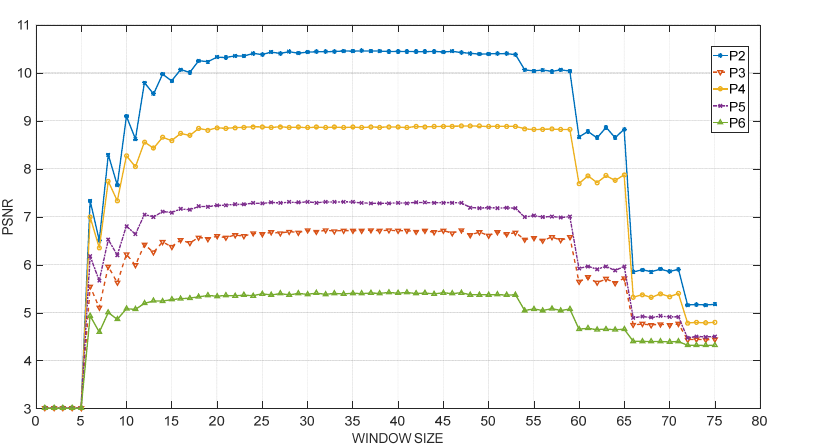
Figure 7. Experimental samples: ( a ) P2; ( b ) P3; ( c ) P4; ( d ) P5; ( e ) P6.